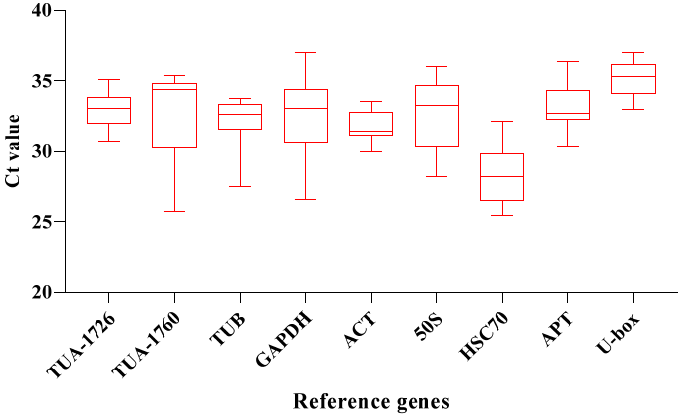
Figure 2. Average CT value of 9 candidate genes. The line across the box represents the median. The boxpoints out the 25th and 75th percentiles. Whiskers represent the maximum and minimum values across all samples.